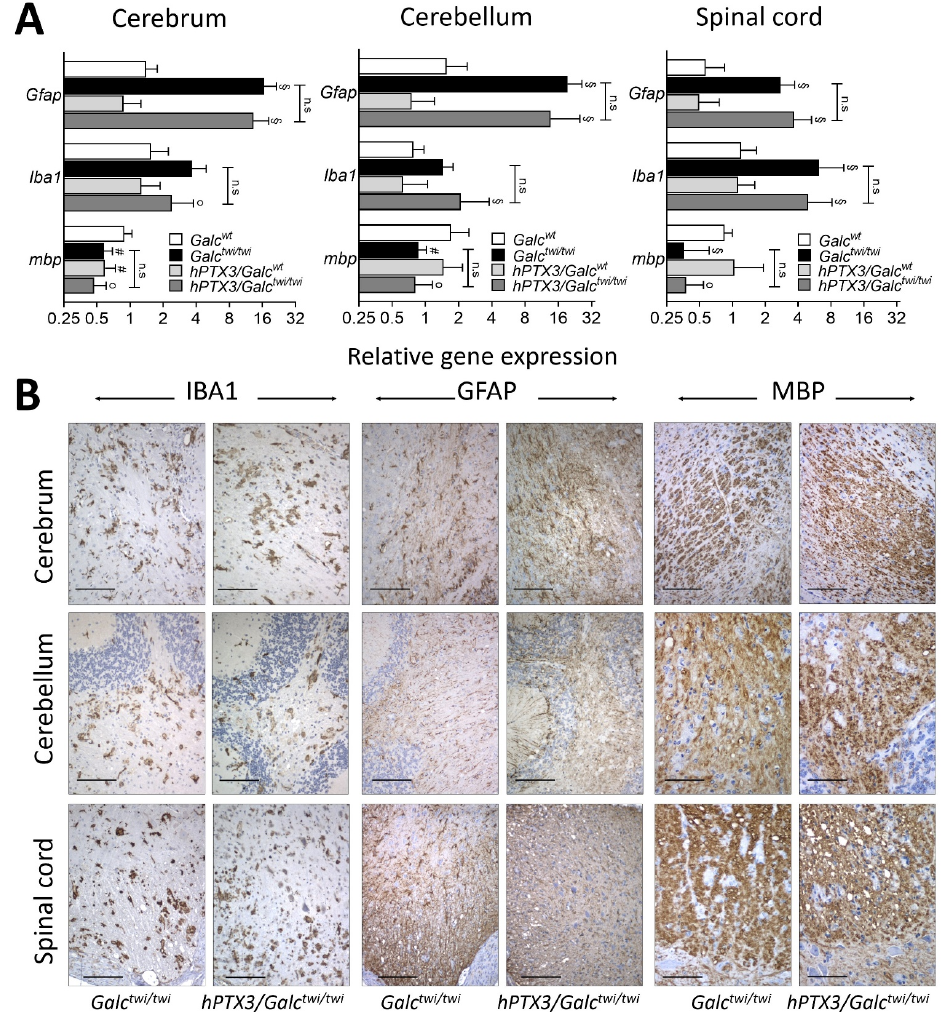
Figure 6. Impact of hPTX3 overexpression on histopathological features of twitcher mice. ( A ) mRNA levels of the indicated genes were evaluated by qPCR in the CNS of P35 hPTX3/Galc wt and hPTX3/Galc twi/twi mice and compared to the corresponding control Galc wt and Galc twi/twi animals. Data were normalized to Gapdh expression and are the mean ± SEM of 7–10 animals per group. n.s., not significant for Galc twi/twi versus hPTX3/Galc twi/twi mice; ° p < 0.05, # p < 0.01, § p < 0.001 for Galc wt versus Galc twi/twi mice or for hPTX3/Galc wt versus hPTX3/Galc twi/twi mice. One-way ANOVA with post hoc comparisons with adjustment for multiple comparisons (Sidak). ( B ) Immunohistochemical analysis shows similar IBA1, GFAP and MBP immunoreactivity (brown) in the CNS of P35 hPTX3/Galc twi/twi mice when compared to Galc twi/twi animals; 20× magnification; scale bar: 100 μ m. In keeping with the lack of a significant impact of constitutive hPTX3 overexpression on the histopathological features of the CNS of GALC-deficient animals, the levels of the neurotoxic GALC substrate psychosine were increased to a similar extent in the CNS of Galc twi/twi and hPTX3/Galc twi/twi animals (Table